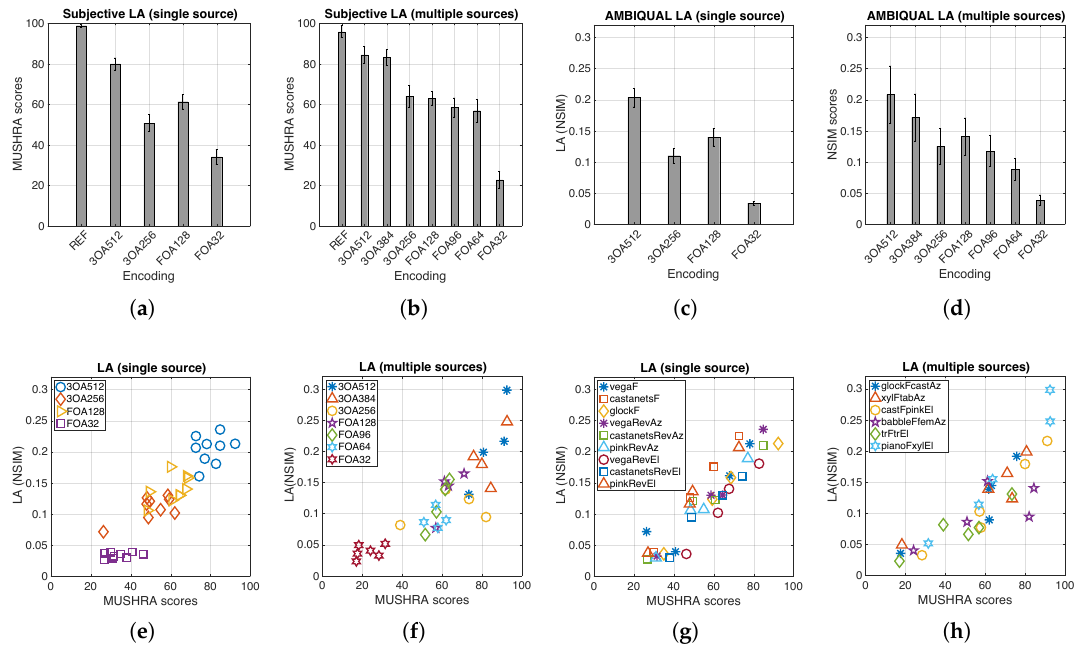
Figure 12. Localization accuracy-subjective vs. AMBIQUAL results: ( a , b ) aggregated subjective localization accuracy scores by encoding scheme (one point audio sources and multi-point audio sources respectively) showing mean values with 95% confidence intervals shown. Plots ( c , d ) show aggregated AMBIQUAL results by encoding scheme (one and multi-point sources respectively). Plots ( e , f ) scatter of subjective vs. AMBIQUAL results by encoding (one and multi-point sources respectively), ( g , h ) scatter of subjective vs. AMBIQUAL results by sample type (one and multi-point sources respectively).